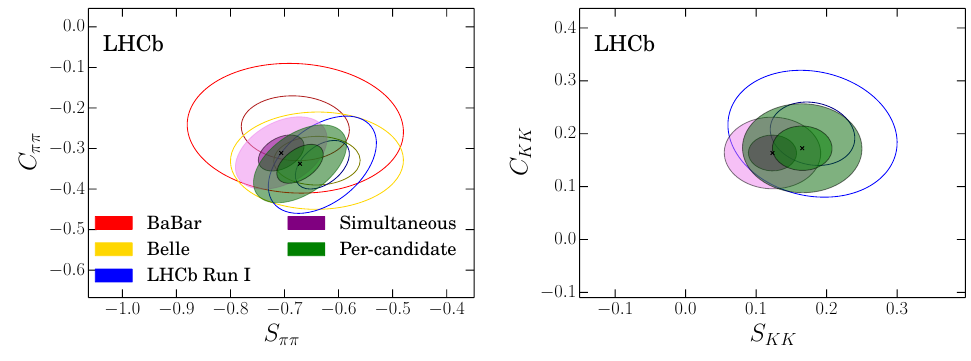
Figure 9 . Two-dimensional 68% and 95% con(cid:12)dence-level regions for the measured CP -violating parameters of the B 0 (cid:25) + (cid:25) (cid:0) (left) and B 0 K + K (cid:0) (right) decays from the two methods. s ! ! The simultaneous method is shown in purple while the per-candidate method in green. Previous measurements of these parameters are also shown, with the LHCb Run 1 result in blue, the Belle result in yellow and the BaBar result in red. The con(cid:12)dence-level regions are calculated using only the statistical uncertainties of all the measurements. The correlation is found to be approximately 84% for all CP -violating parameters between the simultaneous and per-event